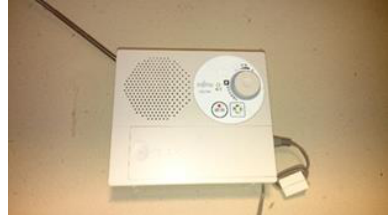
Figure 4. Indoor receiver of the DRS.